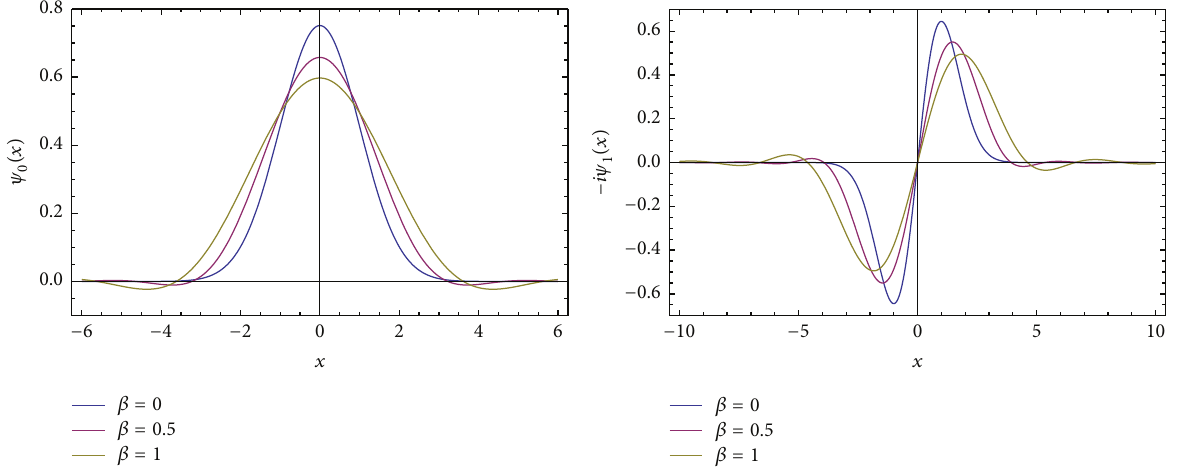
Figure 1: Plots of the position space wave functions for 𝑚 = ℏ = 𝜔 = 1 and 𝑛 = 0,1 .